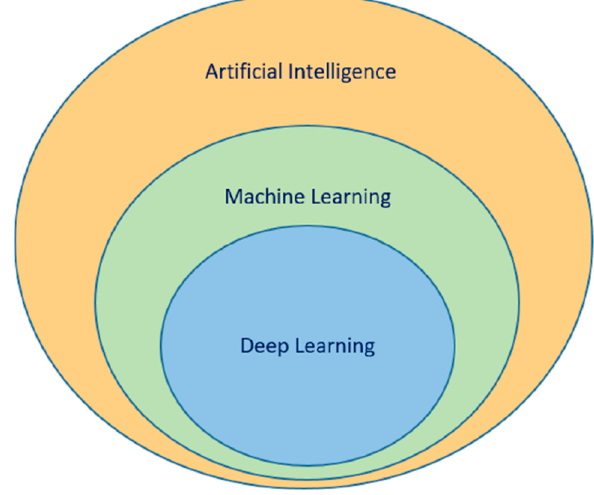
Figure 1. High-level Artificial Intelligence diagram.